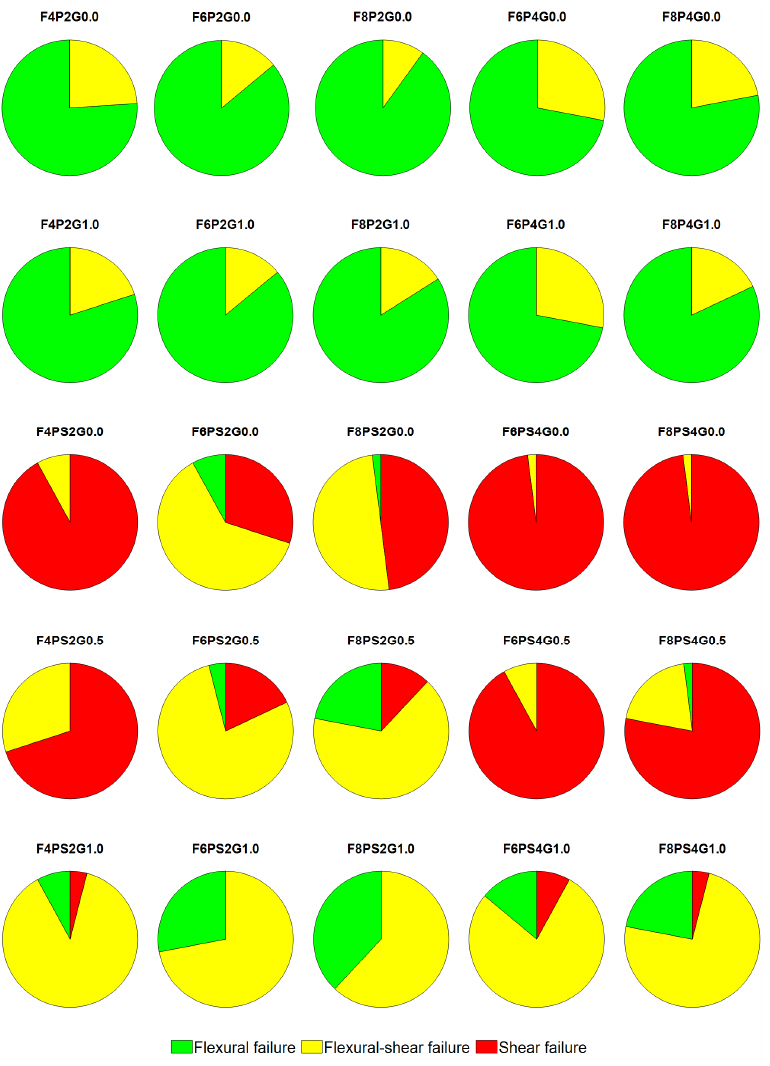
Figure 17. Distribution of types of failure mechanisms for some of the considered pounding configurations.